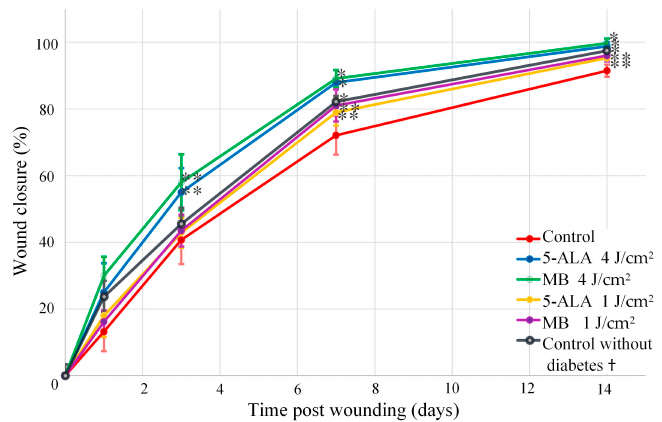
Figure 7. Wound healing progression in the following groups: red line—control, blue line—5-ALA